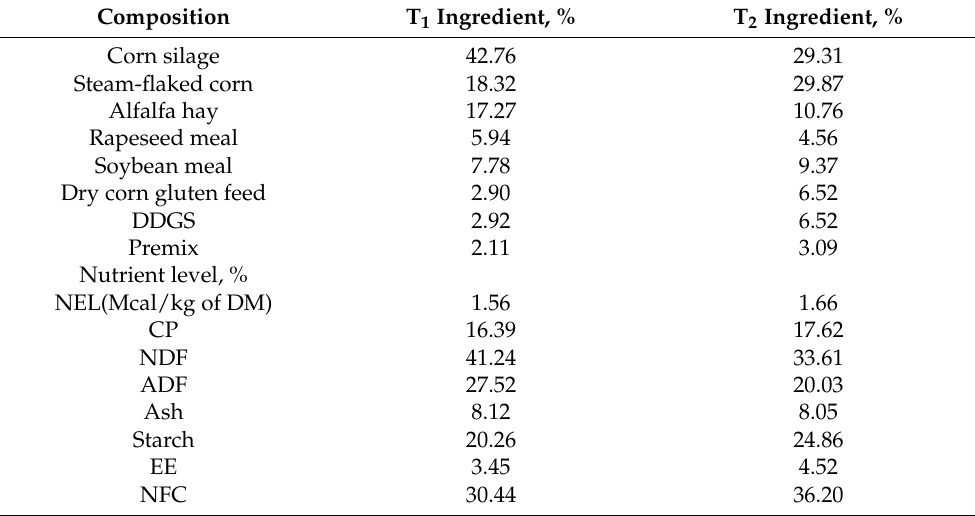
Table 1. Compositions of total mixed rations (TMRs) and conventional nutrients (DM basis). Composition T 1 Ingredient, % T 2 Ingredient, % Corn